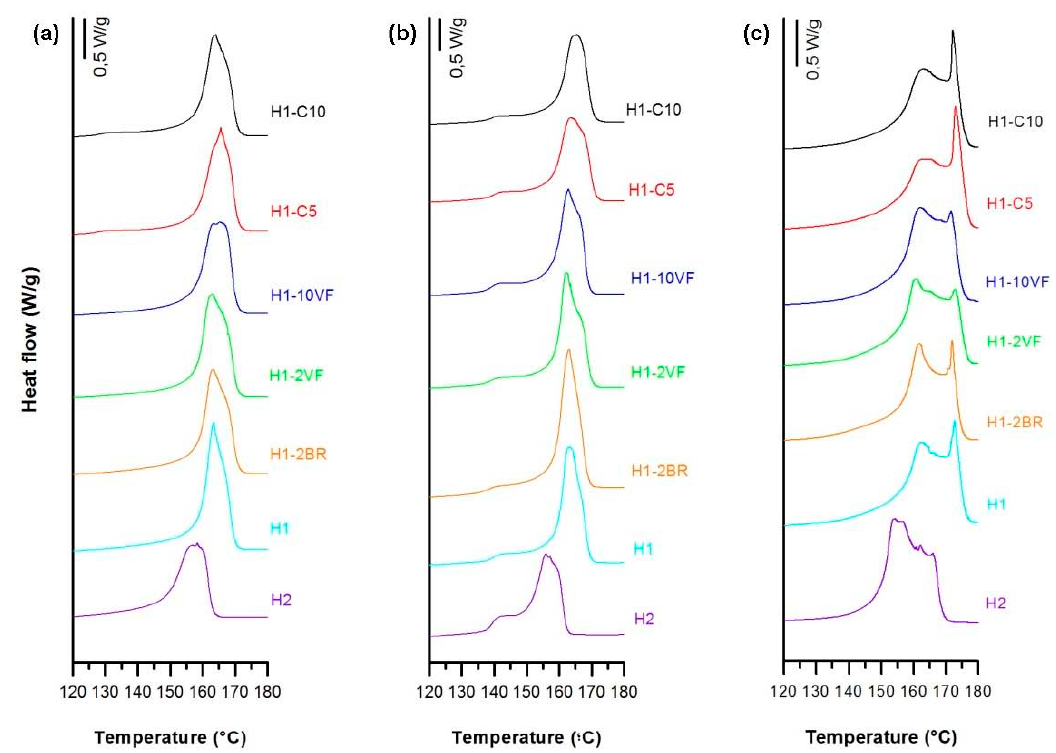
Figure 2. Thermograms differing in sample composition, ( a ) precursor films; ( b ) annealed precursor films; ( c ) membranes.